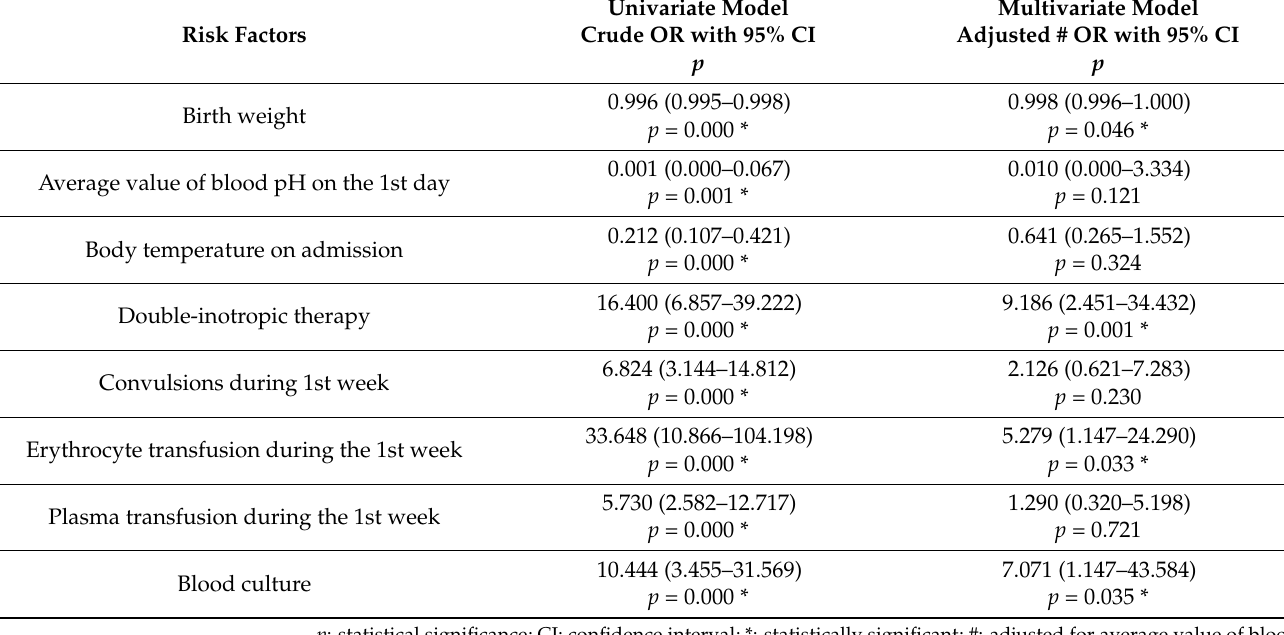
Table 5. Crude and adjusted odds ratios (OR) of the risk factors for fatal outcome in early neona- tal